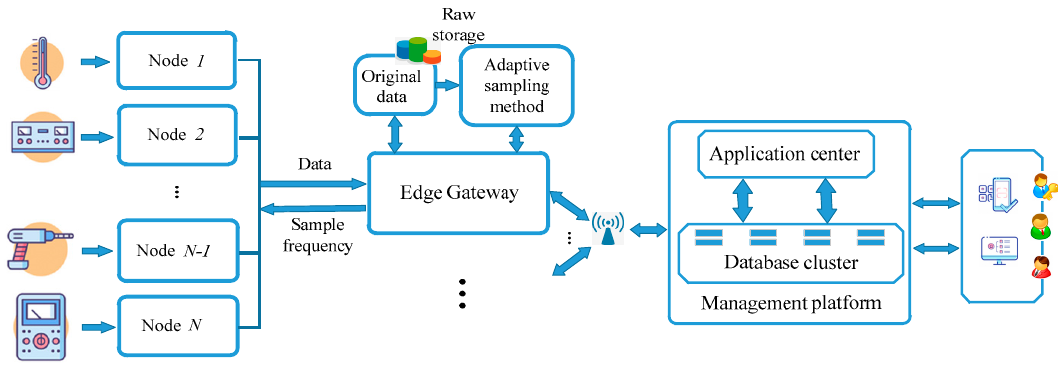
4 of 16 Table 1. Comparison of methods. Spectrum-based